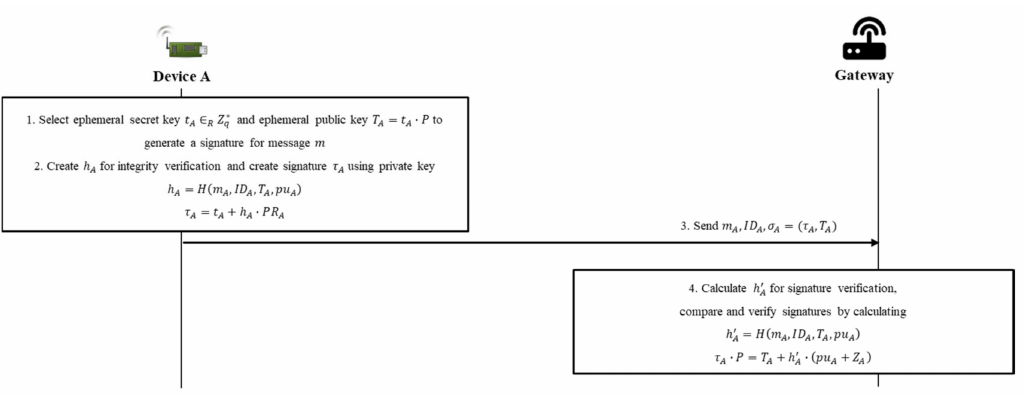
Figure 6. Sequence diagram of individual signing and verifying